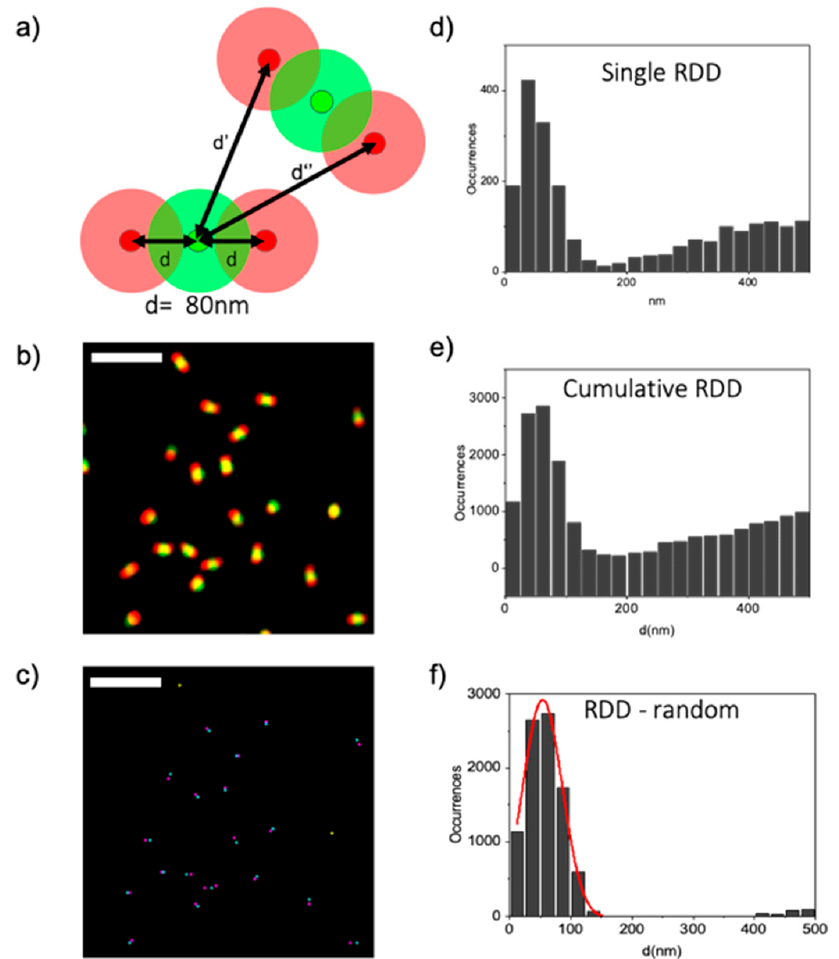
Figure 3. Object-Based analysis of optical nanorulers. ( a ) Schematic representation of the extraction of distances from the object-based analysis. Shaded red and green circles represent the SIM PSF in the two channels. ( b ) 128 × 128 pixels ROI of SIM reconstructed super-resolution image. ( c ) Map of the centers of mass of the identified objects. Magenta and Cyan spots stands for molecules in the red and green channel respectively, whose distance is 30 nm < d <160 nm, whilst the yellow spots stand for structure whose center of mass is closer than 30 nm, which corresponds to our pixel size. ( d ) Relative distance distribution (RDD) histogram calculated from a single 1024 × 1024 SIM image. ( e ) Cumulative RDD histogram of n = 11 samples considered in the analysis. ( f ) Gaussian fit of the RDD histogram without the random component. The analysis of the co-localization peak in all the eleven samples gave a mean distance of d = 54 ± 32 nm (Mean ±